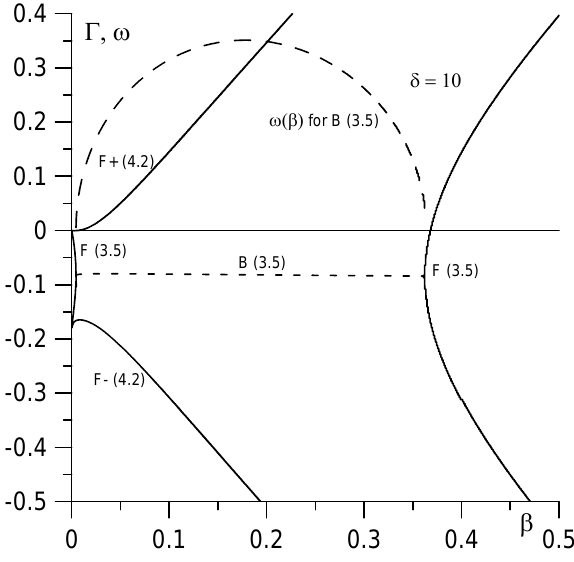
Figure 9. Alfvén-magnetosonic coupling for different ionospheric conductivities. At high conductivity these modes “couple” and at low conductivity they intersect. “A” — Alfvén mode, “S” — slow magnetosonic mode.